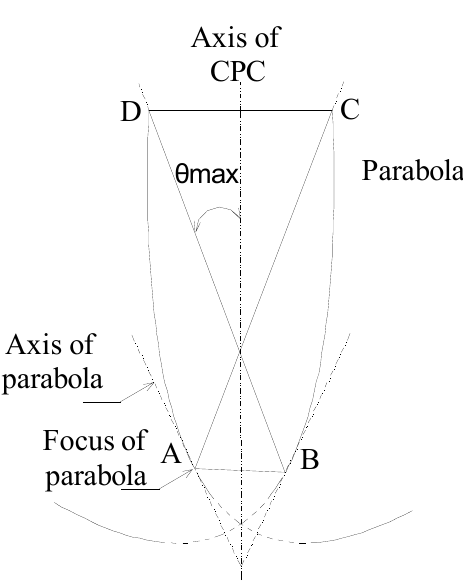
Figure 1. A symmetrical CPC. Axis of CPC D C